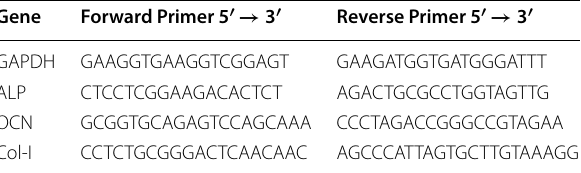
Table 2 RT-PCR primer sequences Gene Forward Primer 5 ′